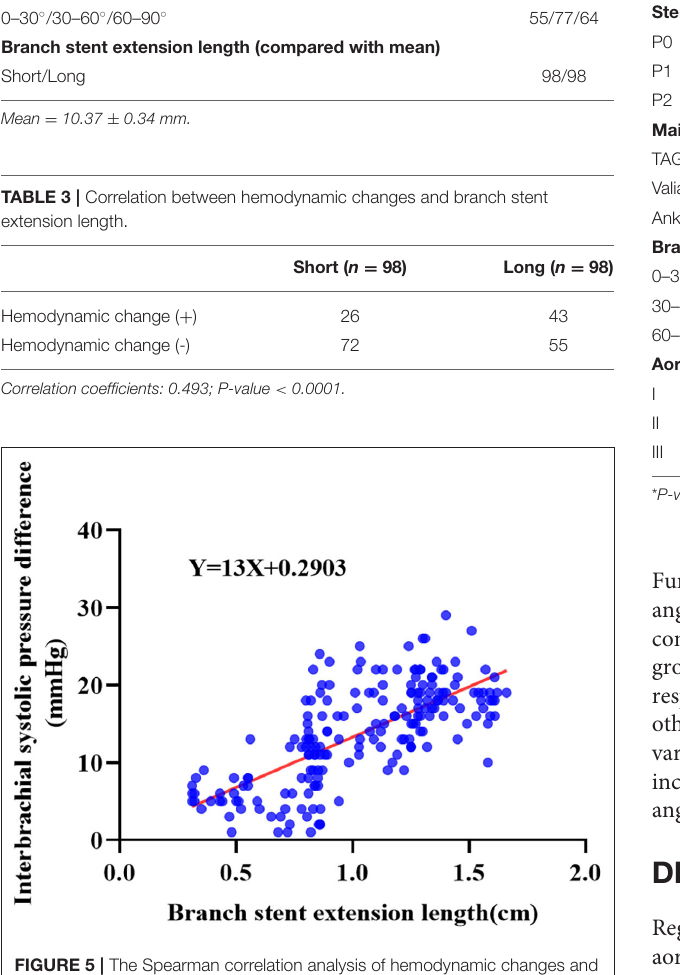
FIGURE 5 | The Spearman correlation analysis of hemodynamic changes and branch stent extension length of the 196 enrolled patients receiving ISF-TEVAR including the LSA fenestration.